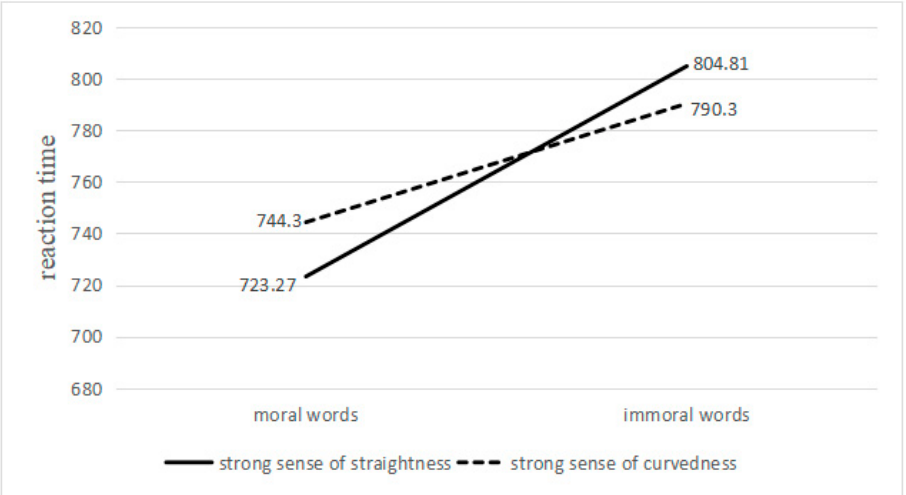
Figure 2. Interaction diagram of word type and font type.